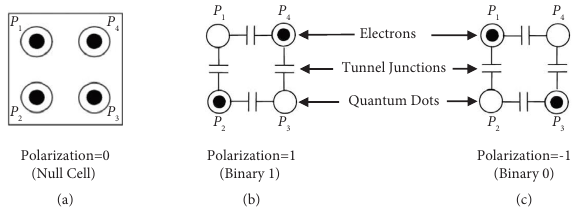
Figure 1: Basic QCA cells. (a) Null cell. (b) QCA cell with polarization � 1. (c) QCA cell with polarization �